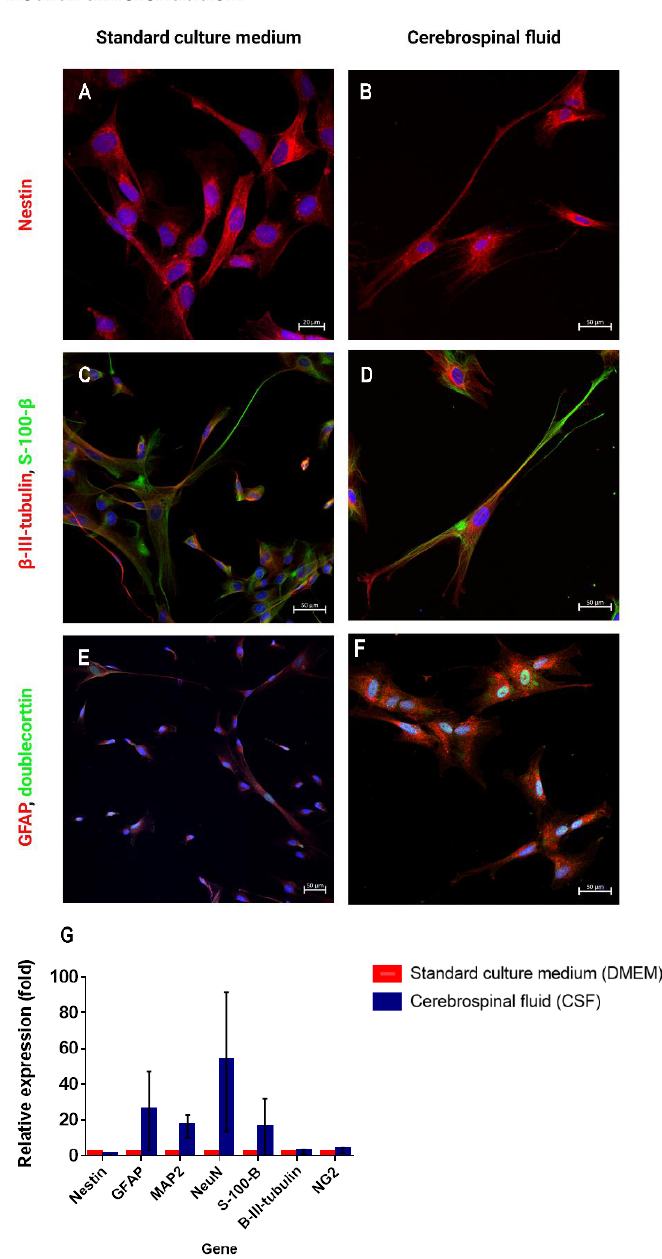
Figure 7. ( A – F ) Immunocytochemistry staining of neural markers in WJ-MSCs cultured in standard culture medium (DMEM) and cerebrospinal fluid (CSF). Scale bars: 20 µm ( A ) and 50 µm ( B – F ). ( G ) RT-qPCR analysis. Relative gene expression level (fold change, mean ± SD, and n = 9) of neural genes in WJ-MSCs cultured in standard culture medium (DMEM) and cerebrospinal fluid (CSF).